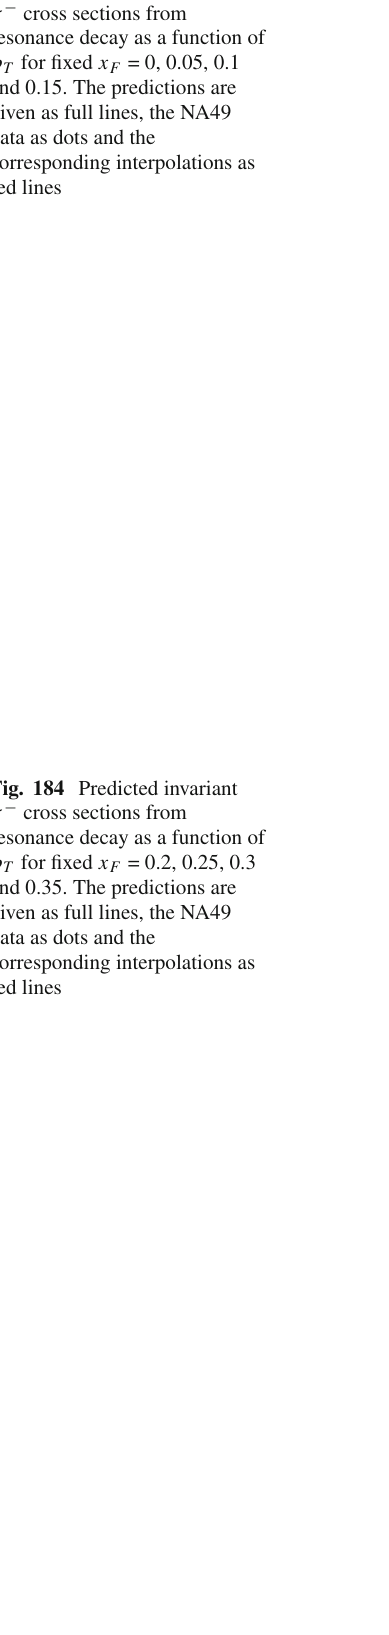
Fig. 183 Predicted invariant π − cross sections from resonance decay as a function of p T for fixed x F = 0, 0.05, 0.1 and 0.15. The predictions are given as full lines, the NA49 data as dots and the corresponding interpolations as red lines